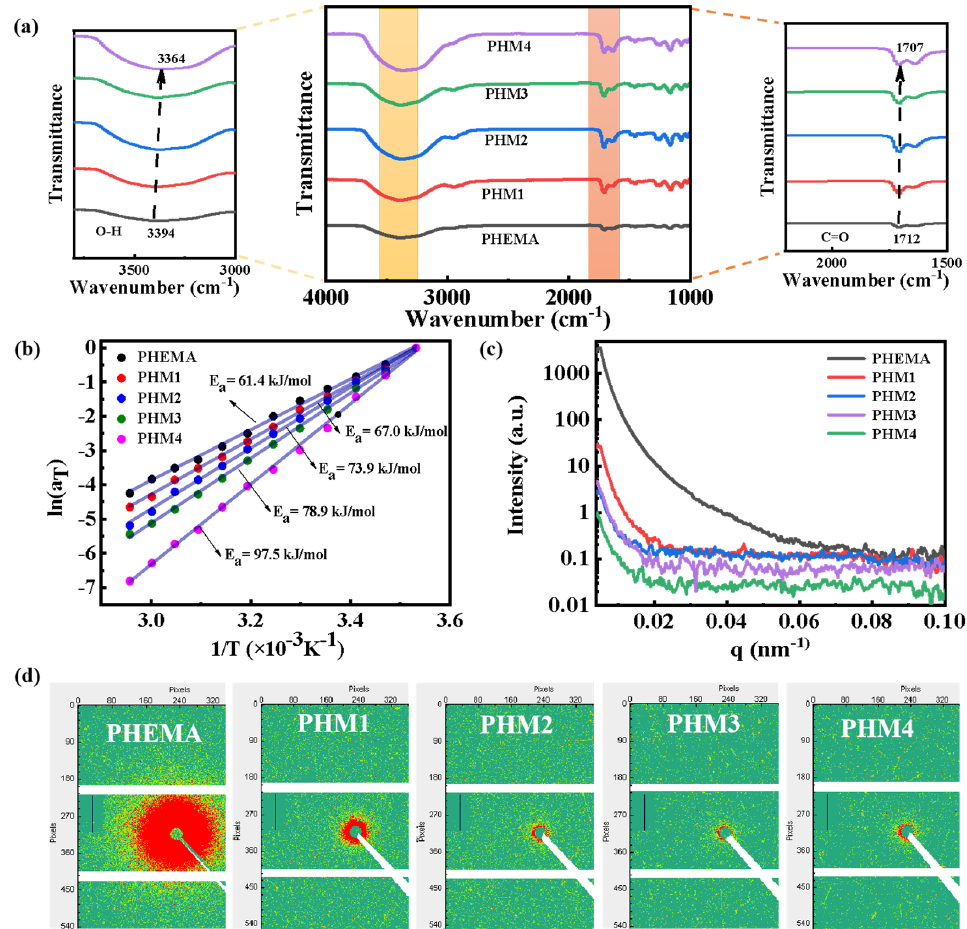
Figure 2. Structural characterization of the hydrogels. ( a ) FT − IR spectra of the PHEMA and PHMx hydrogels. ( b ) Arrhenius plot of horizontal displacement factor a T , and the apparent activation energy E a determined by the slope of the diagram of a T . ( c ) 1D intensity distribution diagrams and ( d ) 2D SAXS diagrams of the PHEMA and PHMx hydrogels.